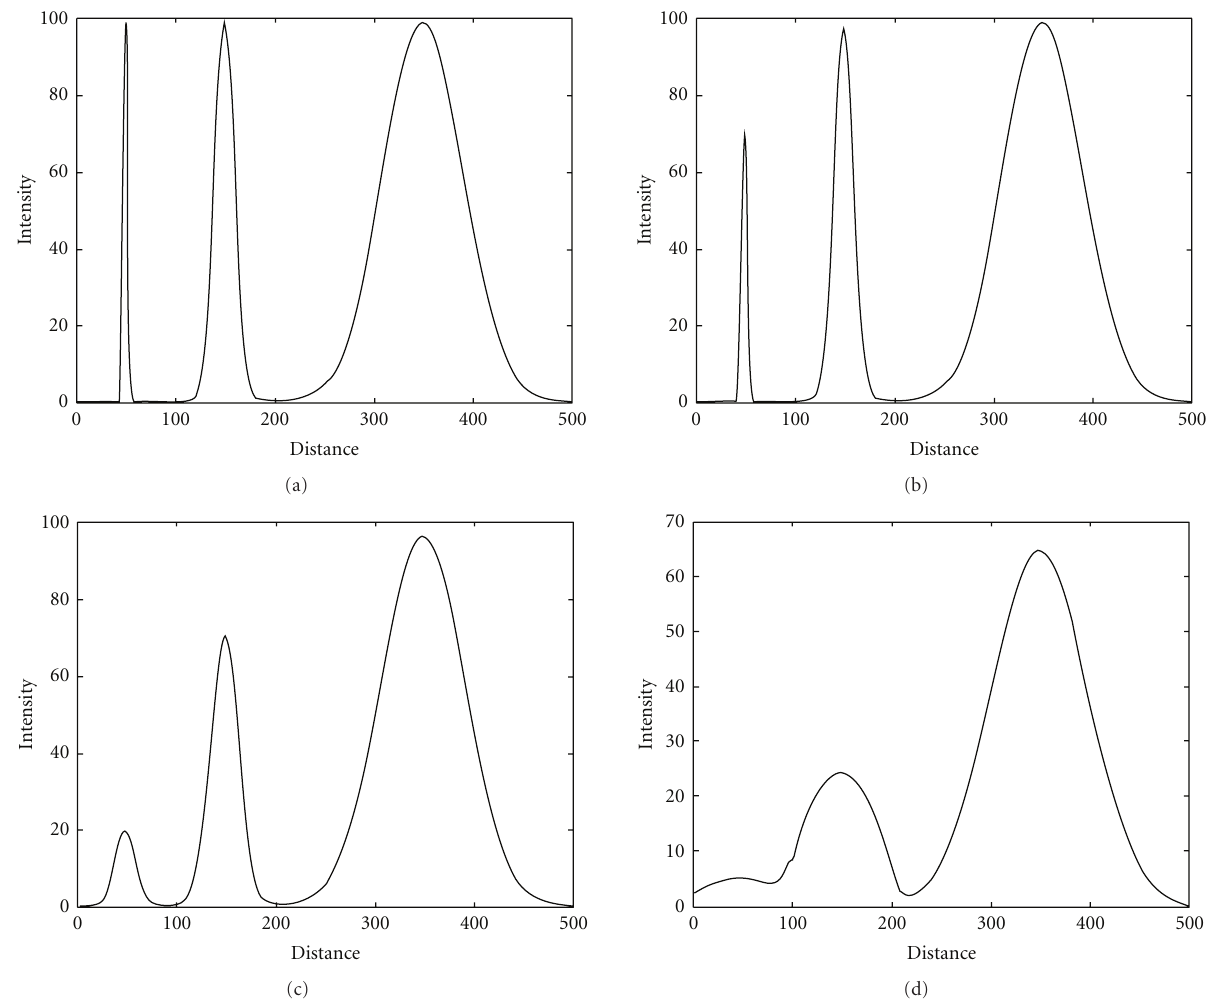
Figure 1: Smoothing the finer spatial image structures out with increase of Gaussian kernel size: (a) original image with structure sizes sigma = 2; 10; 40 (a). Convolution with Gaussian using various kernel size sigma = 2 (b), 10 (c), 40 (d). With Gaussian kernel size increasing, finer image structures are